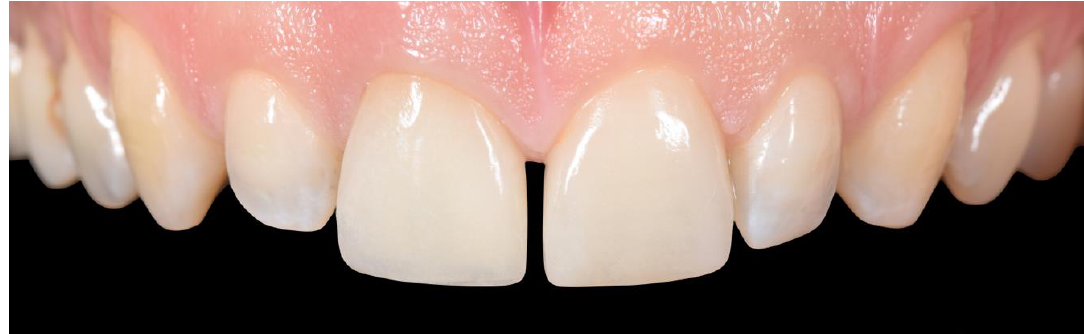
Figure 19. Final prostheses installed.